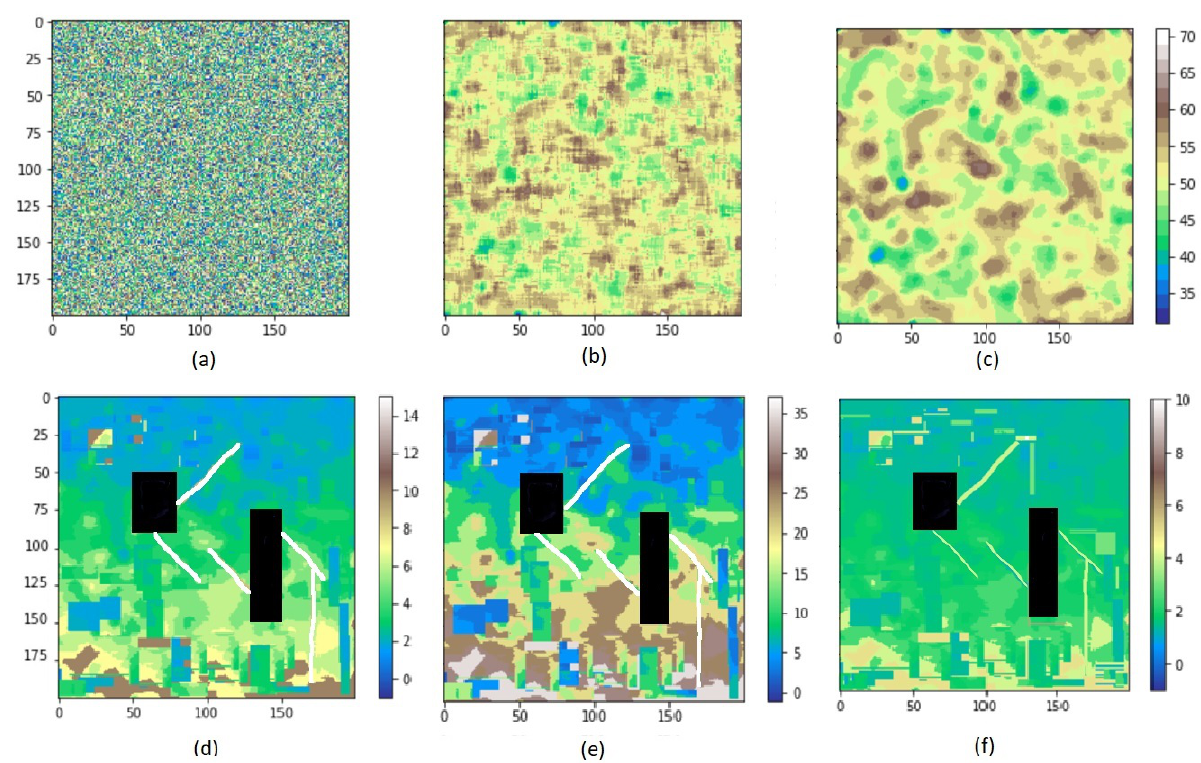
Figure 17. Applying the MLTG method on a wide area consisting of 200 by 200 cells to find a three-mode corridor where the first mode, highway, is a three-cell-wide, the second one, railway, a two-cell-wide and the third mode, power transmission line, an only one-cell-wide path. The randomly made cost raster is shown in subfigure ( a ). This cost raster is smoothed two times and the results are shown in subfigures ( b , c ). The cells on subfigure ( c ) are classified using three different methods representing the three mentioned modes and some suitable areas as well as some avoidance areas are added to make it more natural. The final cost rasters for highway, railway and powerline are shown in subfigures ( d – f ), respectively. The black rectangles represent the added lakes which are the avoidance areas.